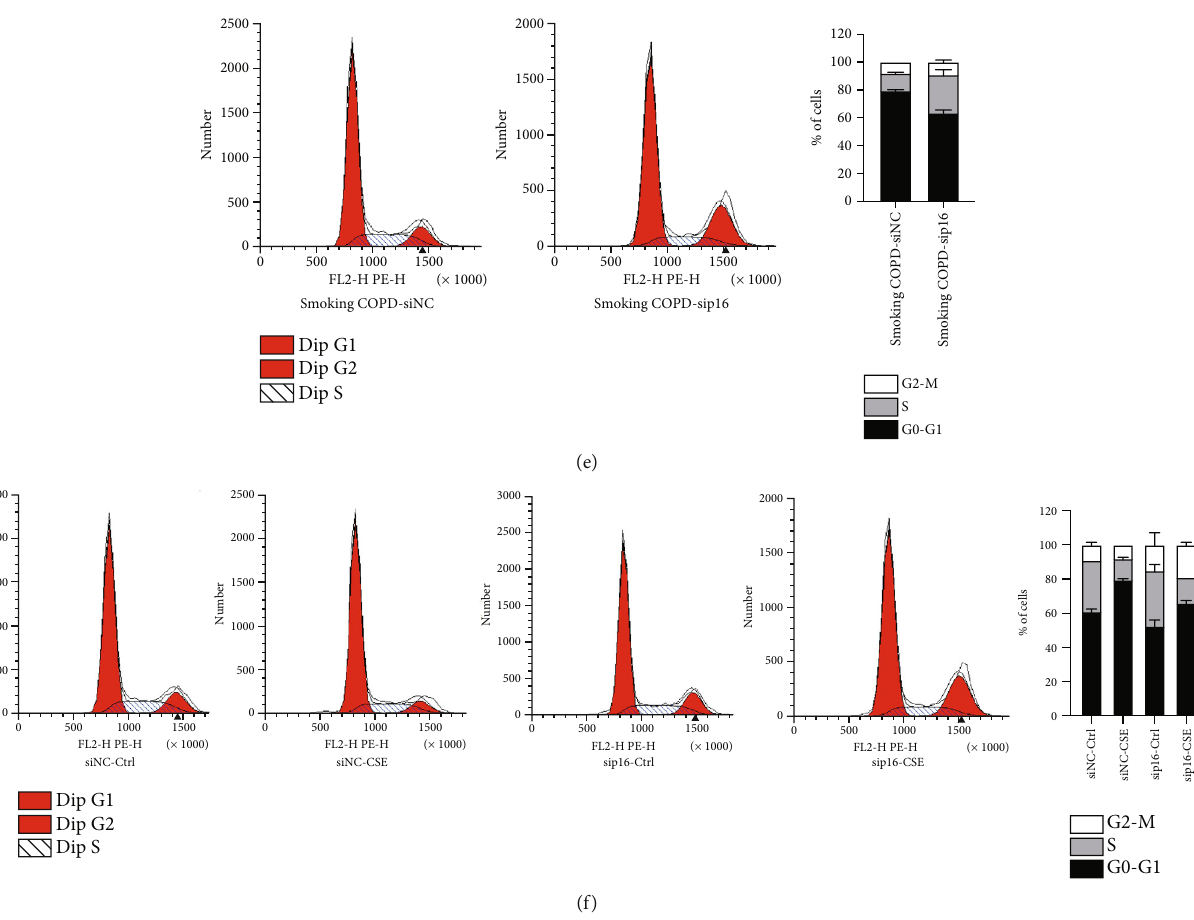
Figure 2: High expression of p16 in EPCs promoted cell cycle arrest and apoptosis. (a) Peripheral blood EPCs were isolated from nonsmoking non-COPD, smoking non-COPD, and smoking COPD patients, and cell proliferation was detected by CCK8. (b) Peripheral blood EPCs of smoking COPD patients were isolated, p16 was knocked down by siRNA, and cell proliferation was detected by CCK8. (c) Peripheral blood EPCs from nonsmoking non-COPD were treated with 5% CSE, p16 was knocked down by siRNA, and cell proliferation was detected by CCK8. (d) Peripheral blood EPCs were isolated from nonsmoking non-COPD, smoking non-COPD, and smoking COPD patients, and cell cycle was detected by fl ow cytometry. (e) Peripheral blood EPCs from smoking COPD patients were isolated, siRNA knocked down p16, and cell cycle was detected by fl ow cytometry. (f) Peripheral blood EPCs from nonsmoking non-COPD patients were treated with 5% CSE, p16 was knocked down by siRNA, and cell cycle was detected by fl ow